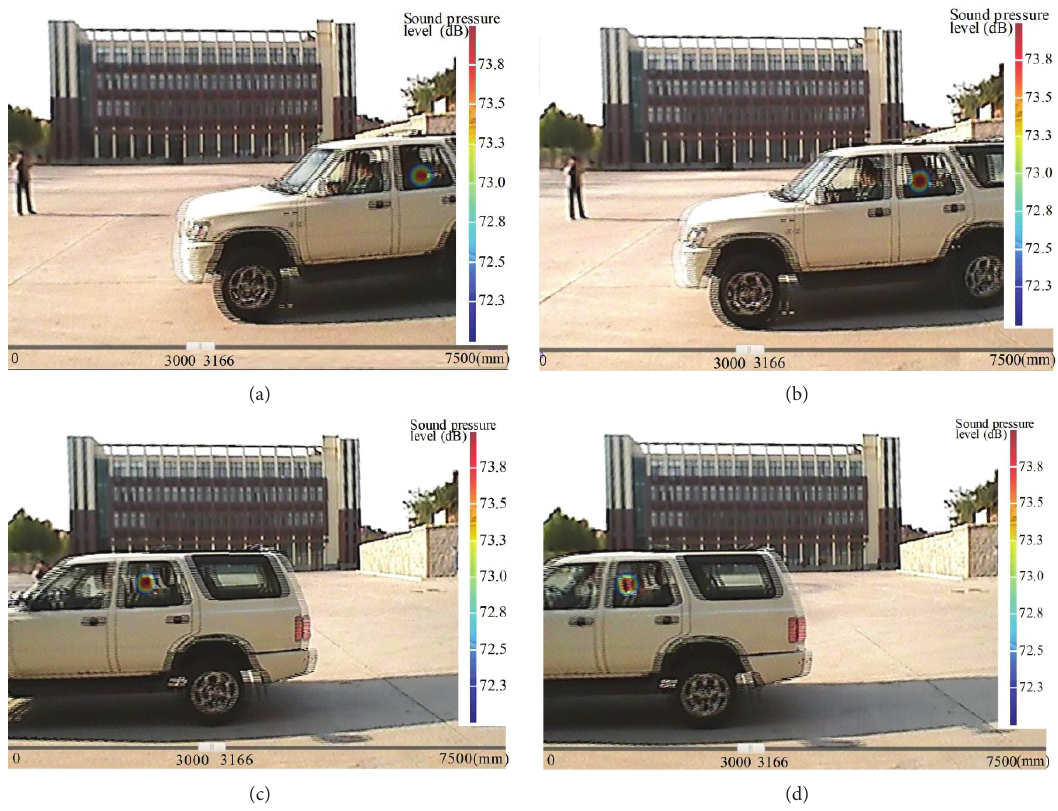
Figure 14: Acoustic maps of partition array with different time: (a) 0.47s; (b) 0.49s; (c) 0.51s; (d) 0.53